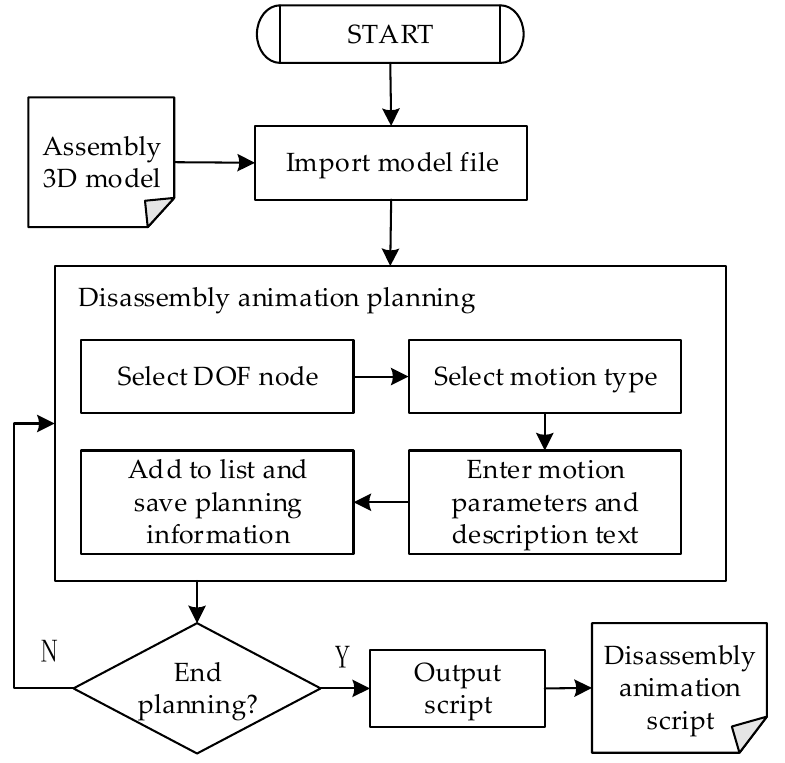
Figure 3. The flow chart of the assembly disassembly animation planning unit.